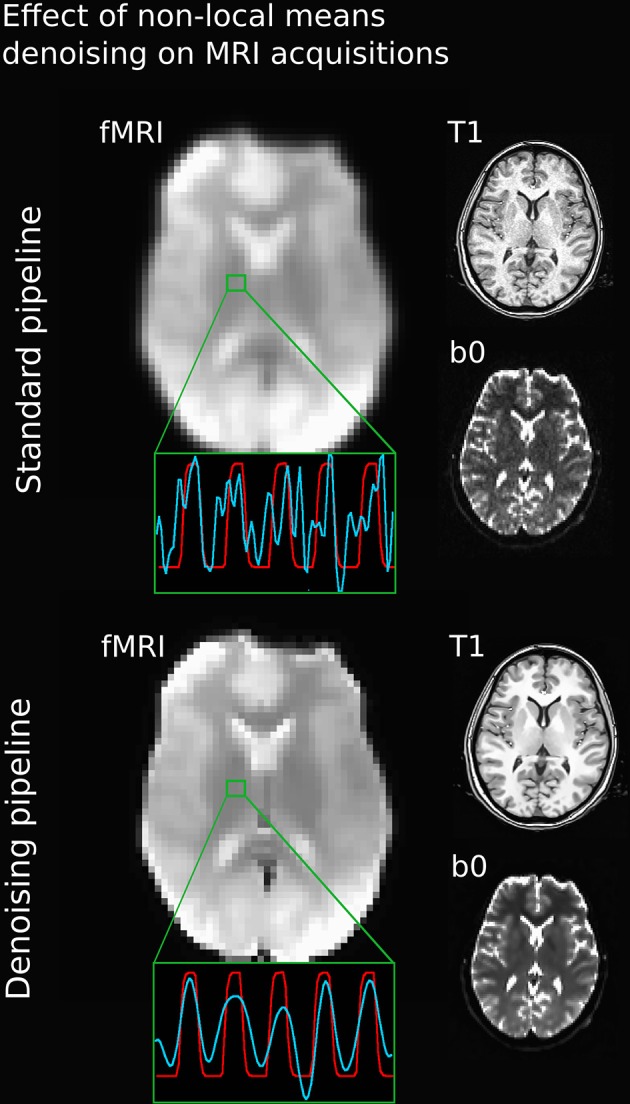
Comparison between various MRI acquisitions with 5 mm Gaussian smoothed (top) and NLM-denoised (bottom) fMRI images. Green square represents a single voxel within the thalamus with BOLD (blue) and stimulus (red) waveform after the processing pipeline. Note how all image types and BOLD signal appears sharper after NLM denoising. Even if a temporal filtering effect can be seen on the denoising pipeline, it is only the result of an effective spatial denoising: by removing some partial-volume effects, especially present in this area, the temporal signal appeared smoother, as rapid change of intensities (or spikes) had less chance of occurrence. The temporal filtering done afterward is then more efficient.